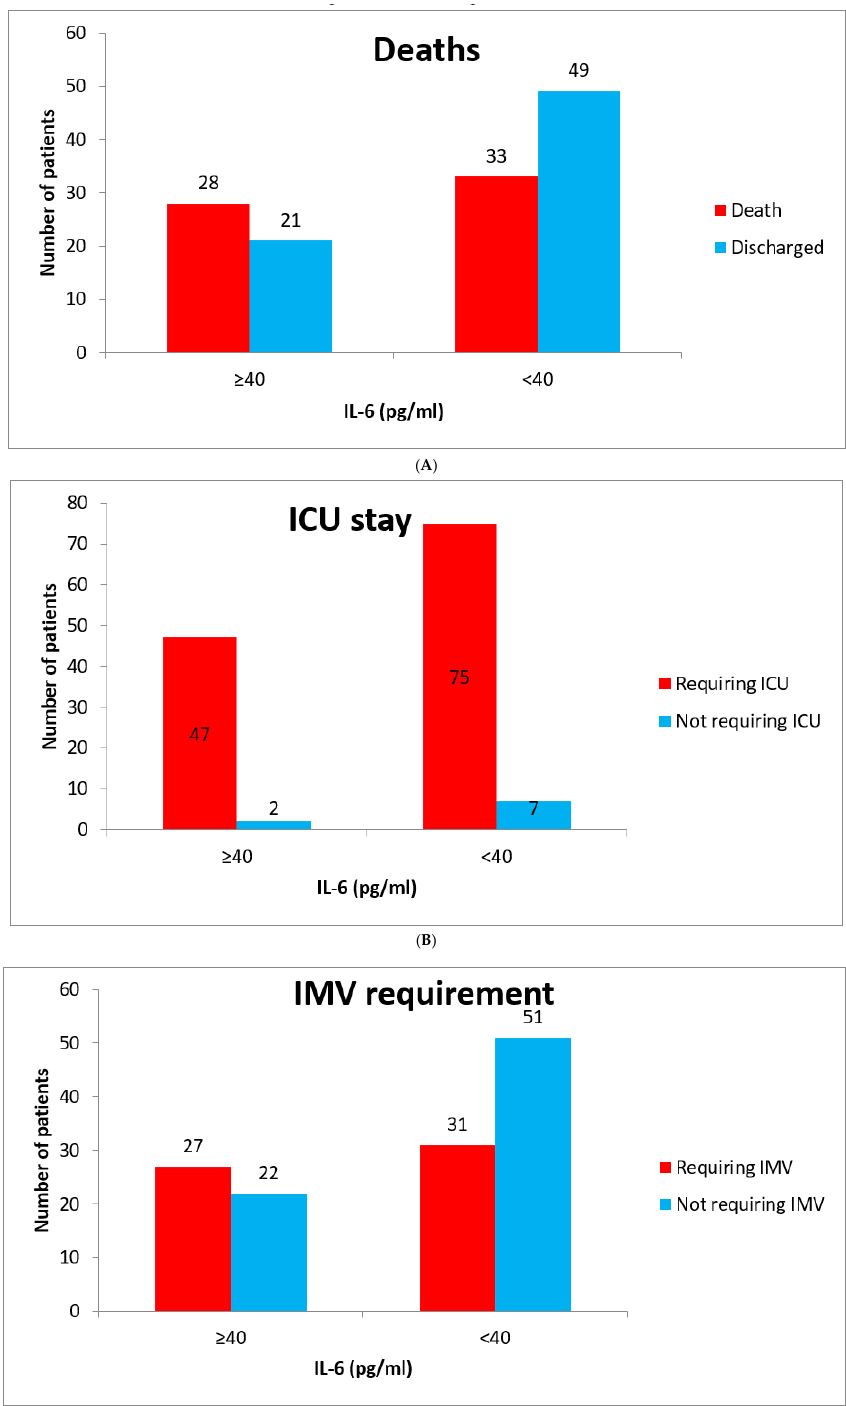
Figure 3. ( A ): Comparison of deaths between the groups. ( B ): Comparison of need for ICU stay Figure 3. ( A ) Comparison of deaths between the groups. ( B ) Comparison of need for ICU stay between the groups. ( C ): Comparison of invasive mechanical ventilation (IMV) requirement be ‐ tween the groups. between the groups. ( C ) Comparison of invasive mechanical ventilation (IMV) requirement between the